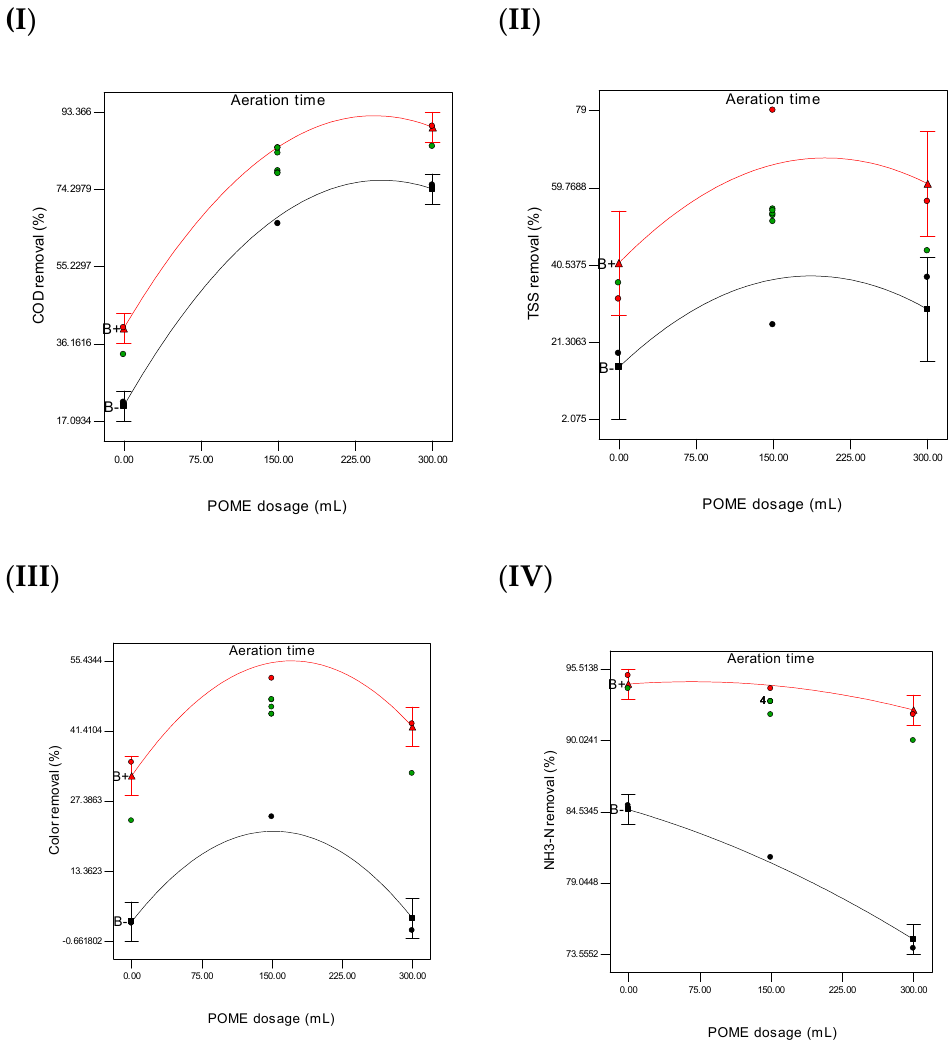
Figure 7. The impact of the POME dose combination and the aeration time for the removal of ( I ) COD, ( II ) TSS, ( III ) color, and ( IV ) NH 3 -N.